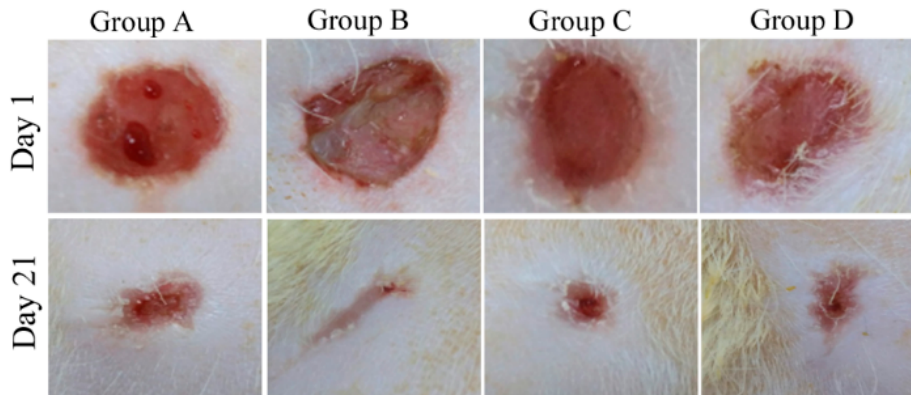
Figure 2. Pictures of wound after different treatments on day 1 and day 21. Notes: ( A ): model group;